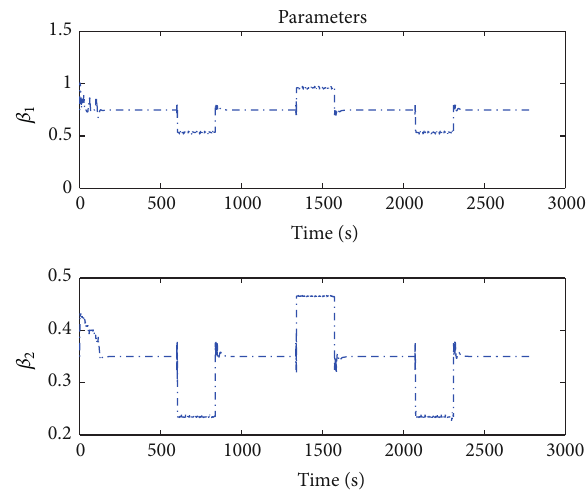
Figure 9: The regulated parameters of 𝛽 𝑙𝑒1 and 𝛽 𝑙𝑒2